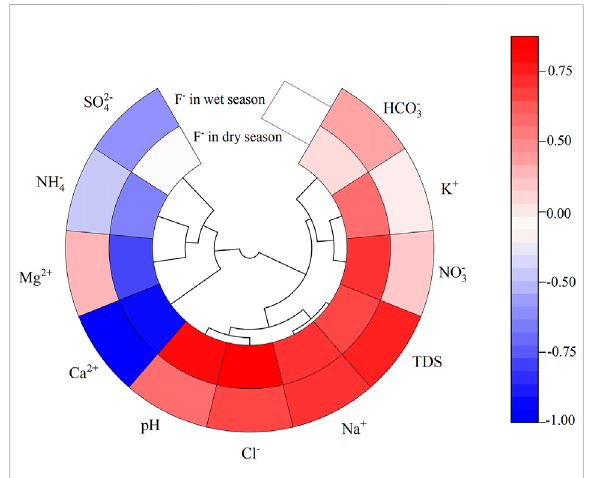
FIGURE 4 Relationships between F - content and the geochemical elements in deep groundwater during the wet and dry